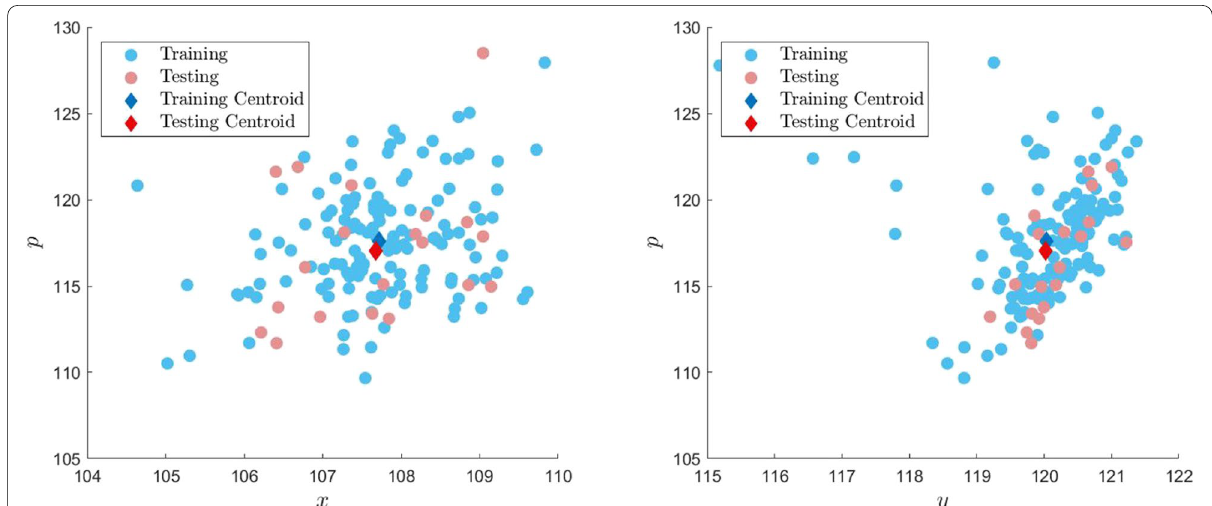
Fig. 20 Comparison of clusters for training and testing datasets of the wooden plate